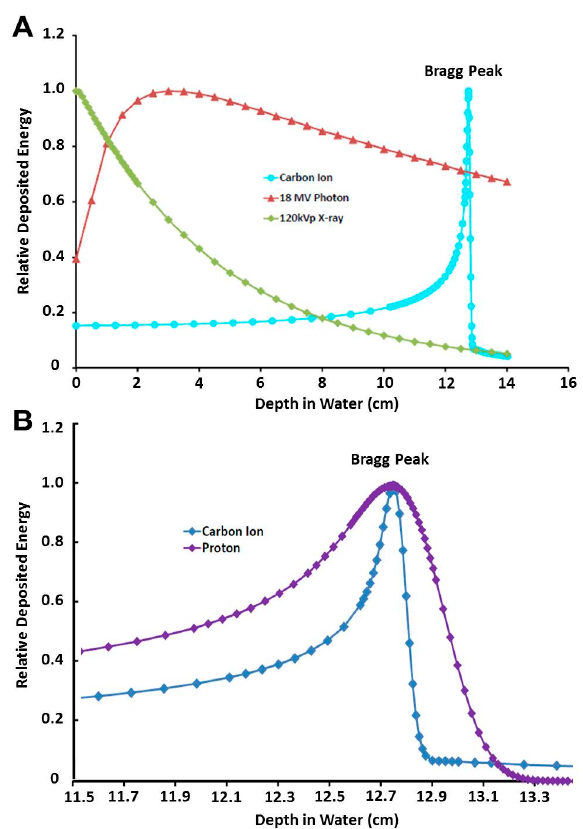
Figure 1. ( A ) Percentage depth dose (PDD) curves comparing carbon ion beams to high (18 MV) and low (120 kVp) energy photon beams. ( B ) Percentage depth dose curves comparing carbon ion to proton beams.